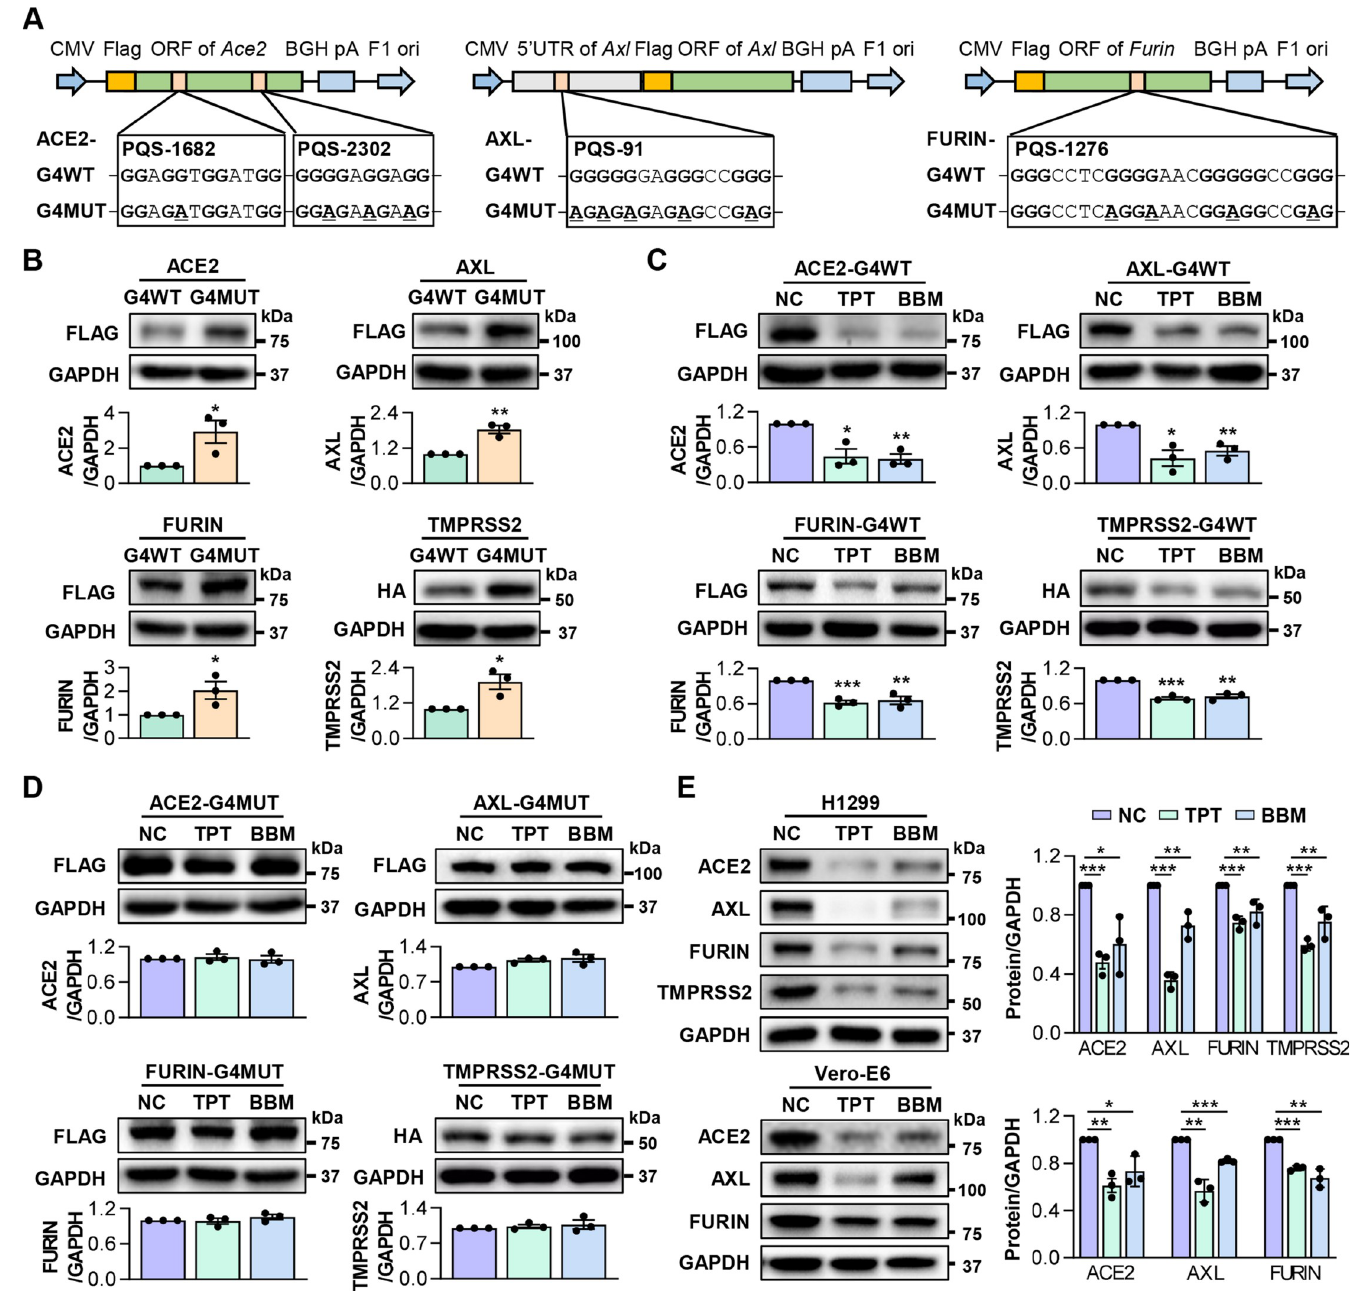
Fig 3. TPT and BBM repress RG4-containing host factors’ expression. (A) A schematic diagram of ACE2/AXL/FURIN-G4WT and their corresponding G4MUT plasmids. For ACE2, full-length ORF of Ace2 (G4WT) or PQS-1682/PQS-2302 G4-mutant Ace2 (G4MUT) were inserted into the MCS of pcDNA3.1 vector. For AXL, full-length 5’UTR of Axl (G4WT) or PQS-91 G4-mutant Axl (G4MUT) were inserted prior to the Axl ORF. For FURIN, full-length ORF of Furin (G4WT) or PQS-1276 G4-mutant Furin (G4MUT) were inserted into the multiple cloning site (MCS) of pcDNA3.1 vector. (B) Protein levels of FLAG-AXL, FLAG-ACE2, FLAG-FURIN and HA-TMPRSS2 in H1299 cells transfected with their respective G4WT or G4MUT plasmids. (C, D) Protein levels of FLAG-AXL, FLAG-ACE2, FLAG-FURIN and HA-TMPRSS2 in H1299 cells transfected with their respective G4WT (C) or G4MUT (D) plasmids in the presence of TPT or BBM. (E) Protein levels of endogenous AXL, ACE2, FURIN and TMPRSS2 in H1299 (top panel) and Vero-E6 (bottom panel) cells treated with TPT or BBM. ImageJ quantification of the target/GAPDH ratio is shown. Data are shown as mean ± SEM, n = 3. � p < 0.05, �� p < 0.01, ��� p < 0.001 (Two-tailed Student’s t test).